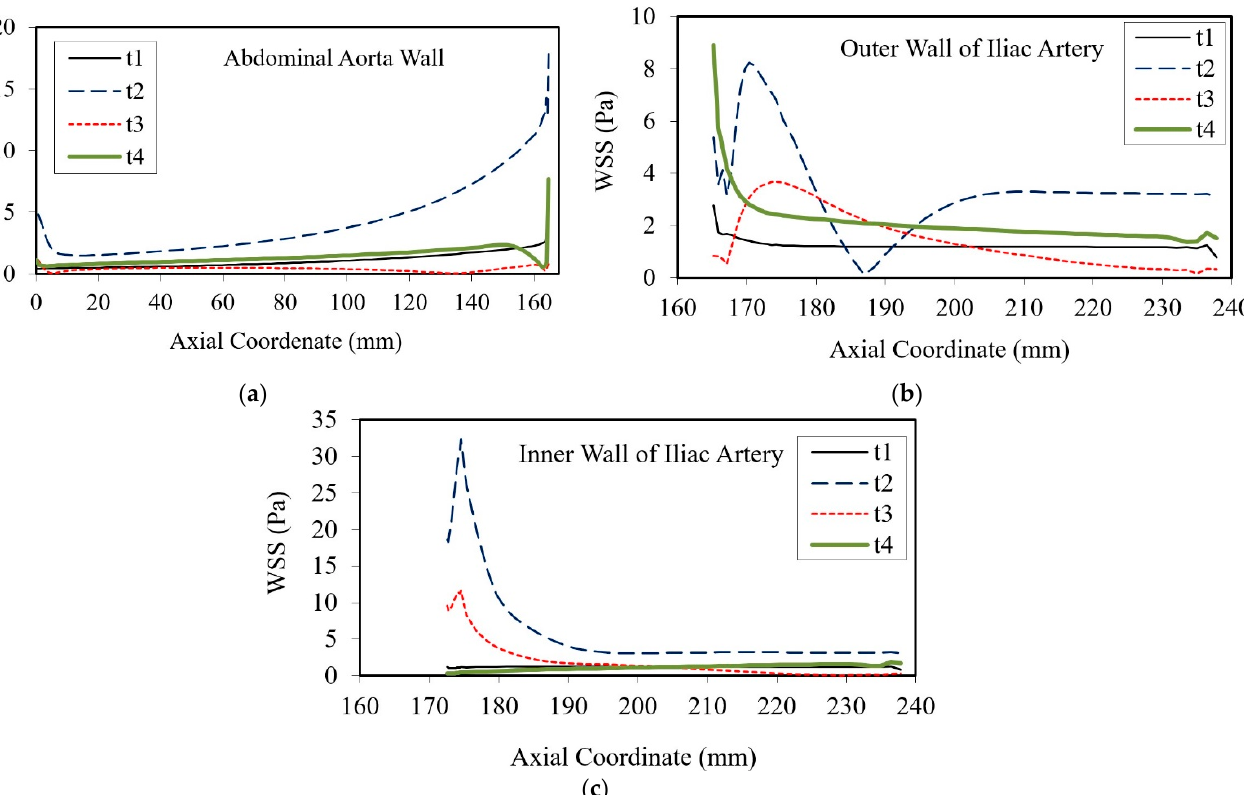
Figure 11. Distribution of WSS at the median x-y plane during the cardiac cycle, ( a ) at the abdominal aorta wall, and at the ( b ) outer and ( c ) inner wall of the iliac artery.